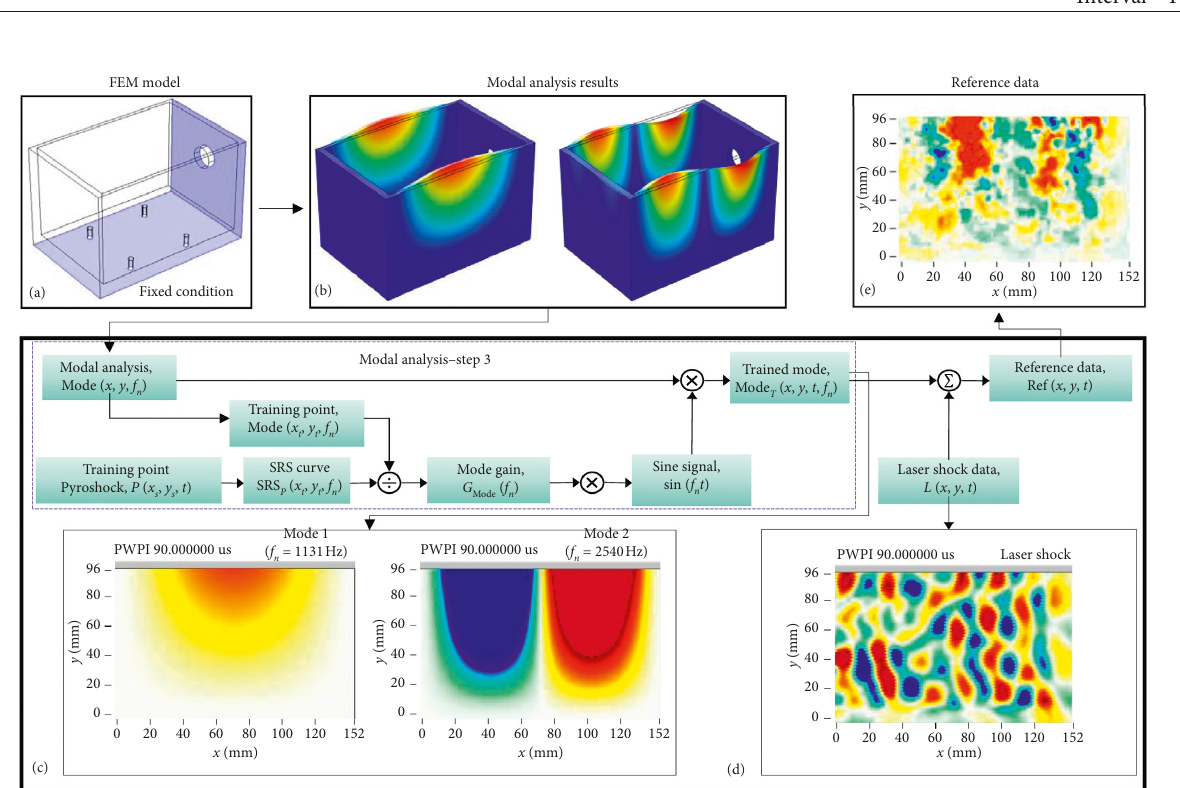
Figure 5: Modal analysis for simulation of pyroshock on the open-box-type tension joint: (a) FEM model, (b) modal analysis results, (c) trained modal analysis data, (d) laser shock data, and (e) reference Figure 4. The data acquisition condition of the laser scanning data is shown in Table 2.